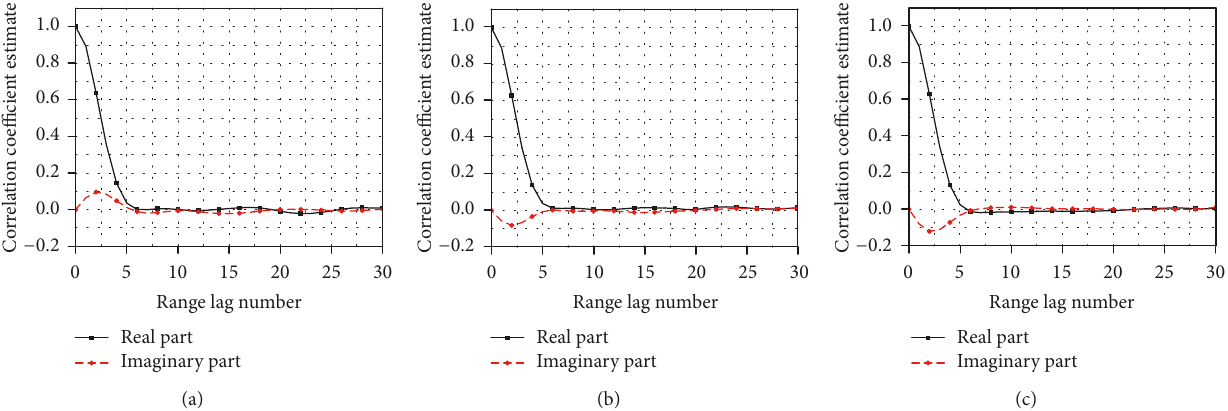
Figure 13: The spatial correlations of the speckle for DS2: (a) Sum channel. (b) Elevation difference channel. (c) Azimuth difference channel.